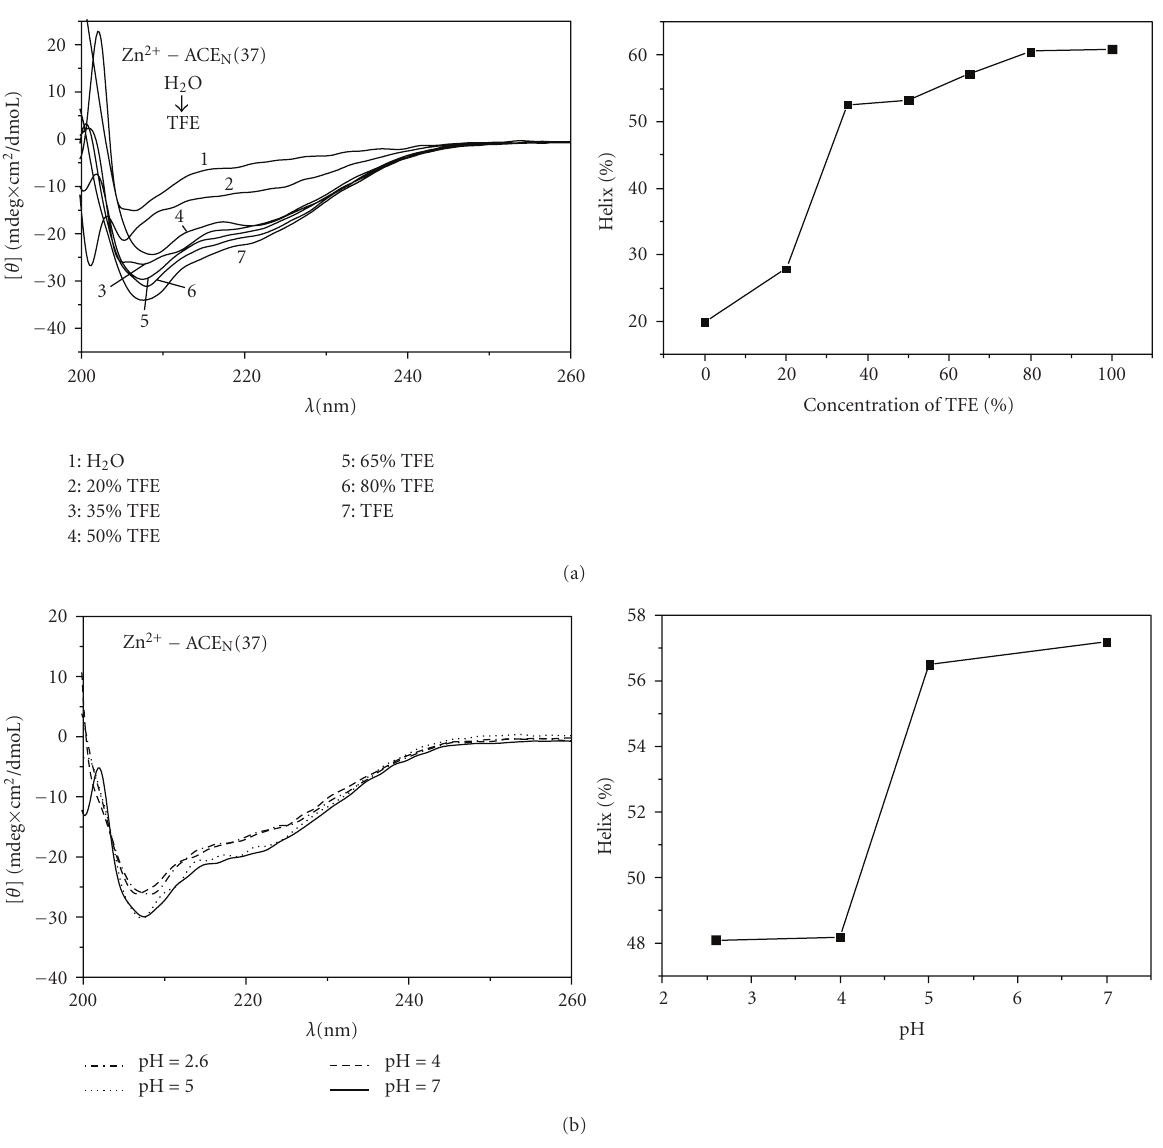
Figure 4: Circular dichroism spectra (left) and corresponding diagrams (right) of helical content through data analysis by CDNN software of (a) 2,2,2-trifluoroethanol (TFE) range from 0% to 100% of Zn 2+ -ACE N (37) samples, at pH = 5 . 0, T = 25 ◦ C, 50 mM Tris-HCl, and 200mM NaCl and (b) of pH range from 2.6 to 7 of Zn 2+ -ACE N (37) samples, at 65% TFE, T = 25 ◦ C, 50 mM Tris-HCl, and 200 mM